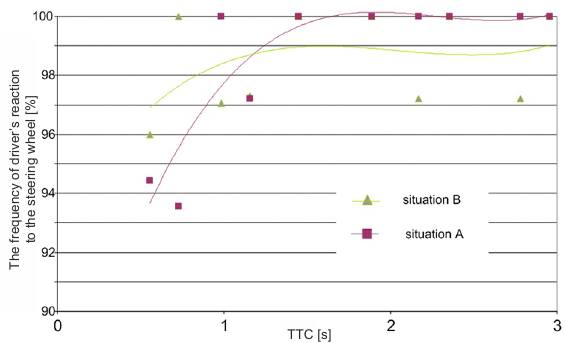
Fig. 18. The values of the frequency of the driver’s reaction to a steering